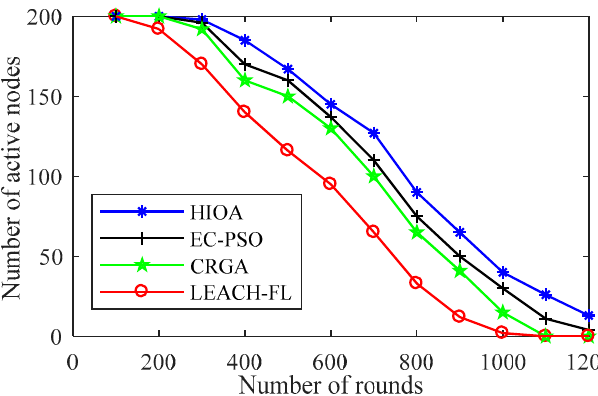
Figure 5. Number of active nodes over round.